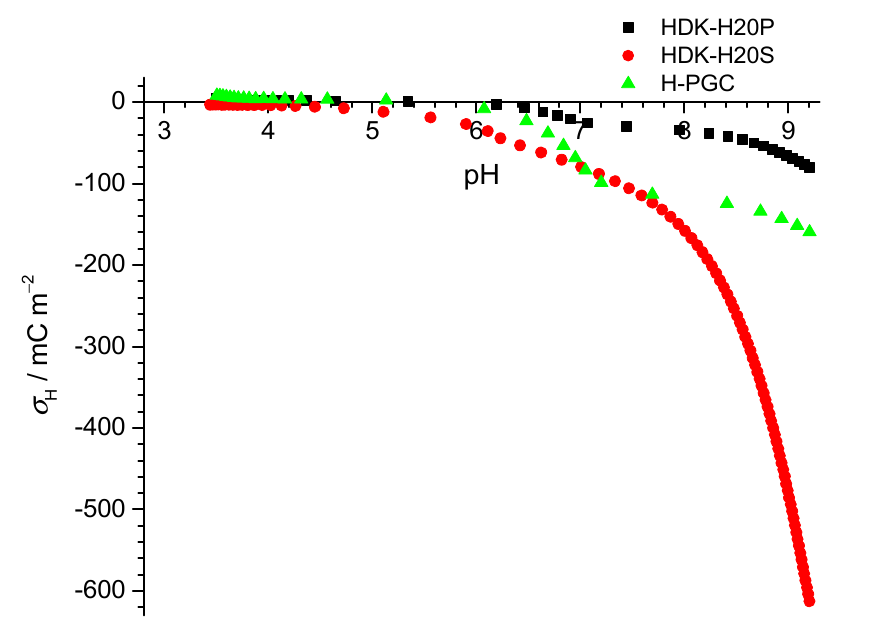
Figure 3. Surface charge of graphite ( ▲ , H-PGC), hydrophobic silica ( ■ , HDK-H20P), and hydrophilic silica ( ● , HDK-H20S) obtained by mass titrations in sodium chloride aqueous ( I c = 1 mmol dm − 3 ) solution, θ = 25 °C.